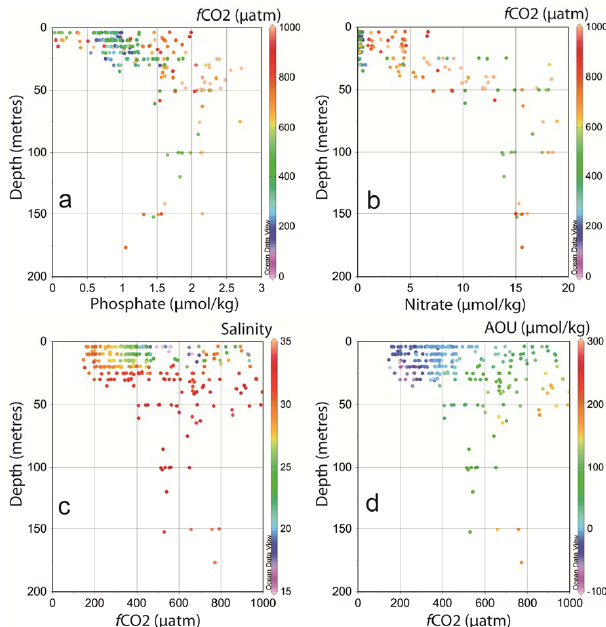
Fig. 8. Depth profiles of phosphate (a), nitrate (b), both color coded by f CO 2 , and f CO 2 color coded by salinity (c) and by AOU (d).